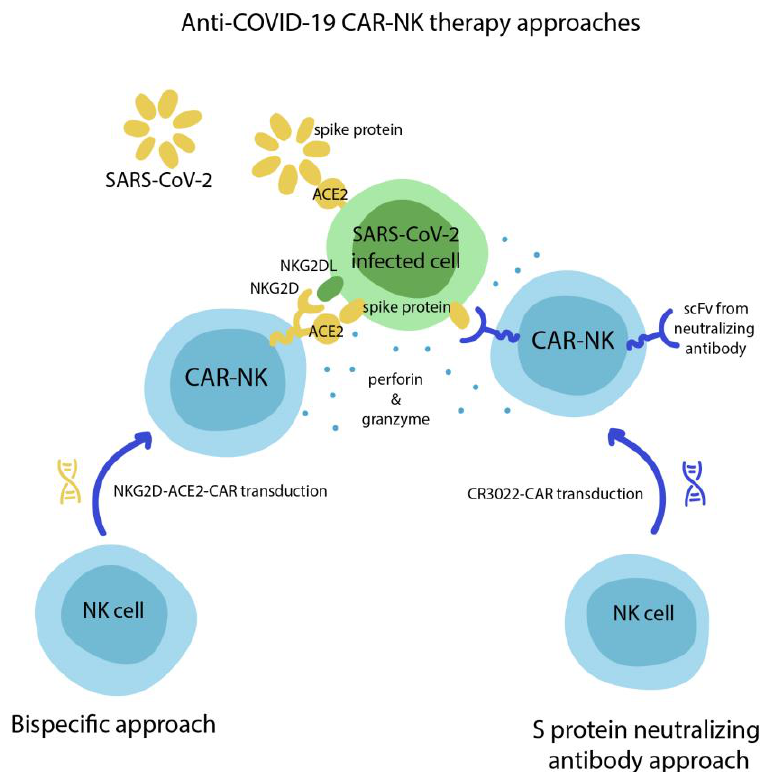
Figure 3. Experimental approaches for anti-COVID-19 CAR-natural killer (NK) therapy. One is based on bispecific recognition of infected cells through ACE2-S protein and NKG2D-NKG2DL interactions ( left ), while another uses classical single-chain variable fragments from an S protein neutralizing antibody ( right ).